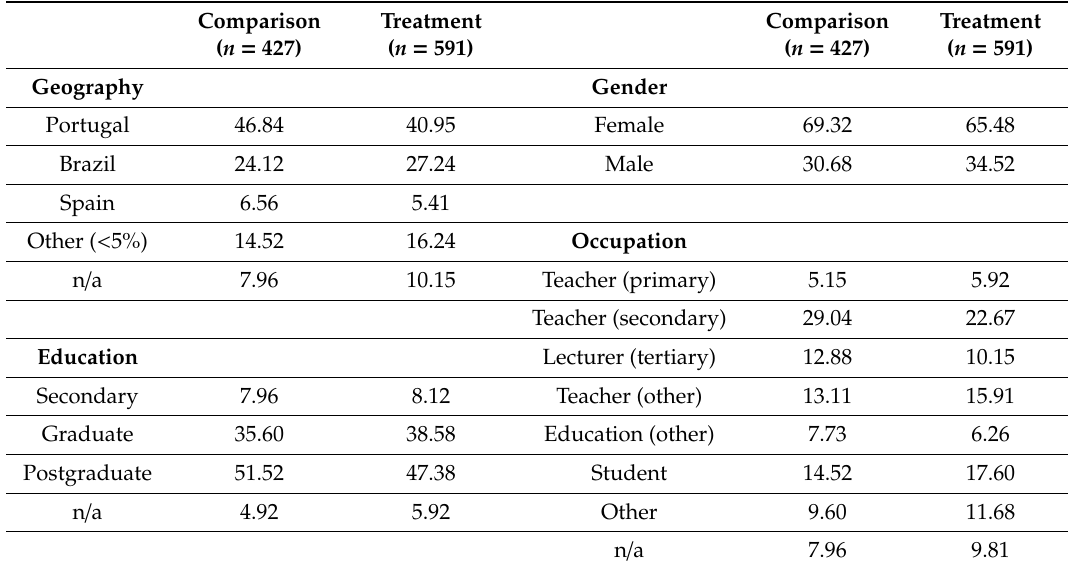
Table 1. Geographic location, gender, educational background and occupation of participants as a percentage of the